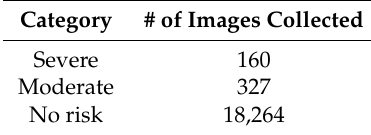
Table 13. Risk Classification from keyword search with Twitter.